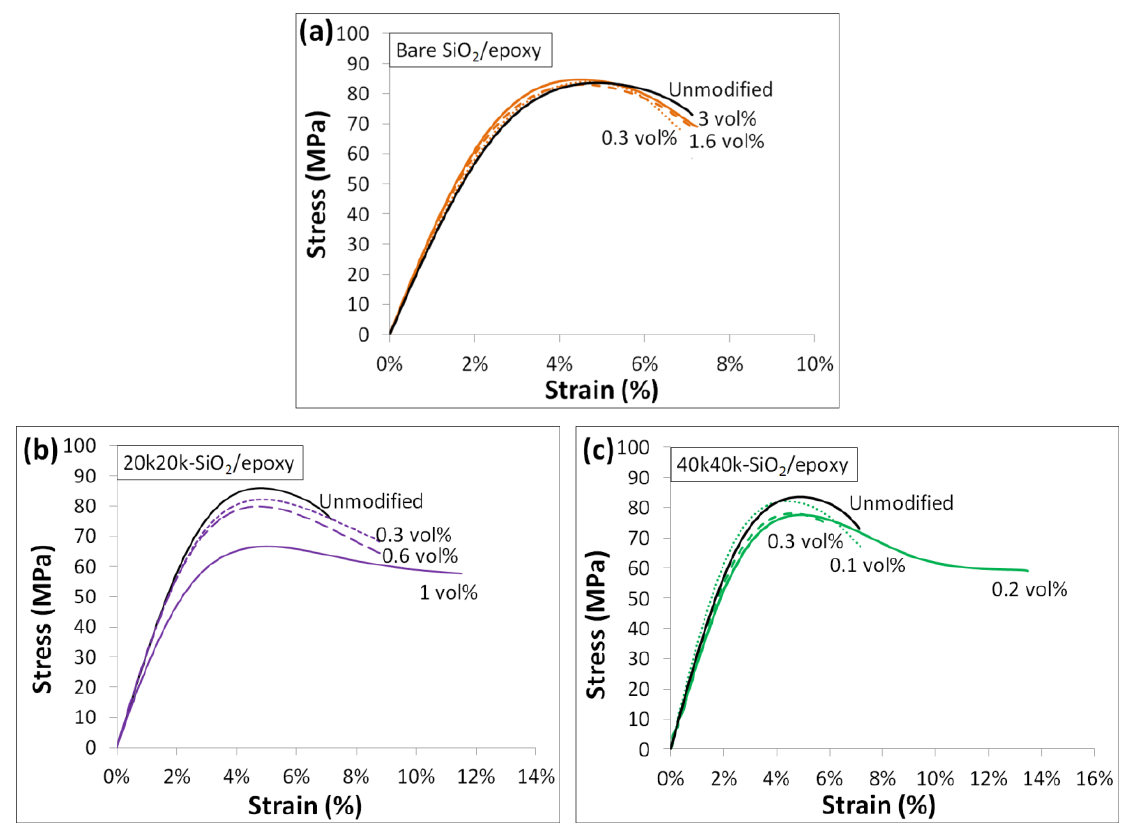
Figure 9. Representative stress strain curves for ( a ) bare SiO ( b ) 20k20k-SiO /epoxy nanocomposites; and ( c ) 40k40k-SiO 2 different volumetric loadings of SiO cores. 2